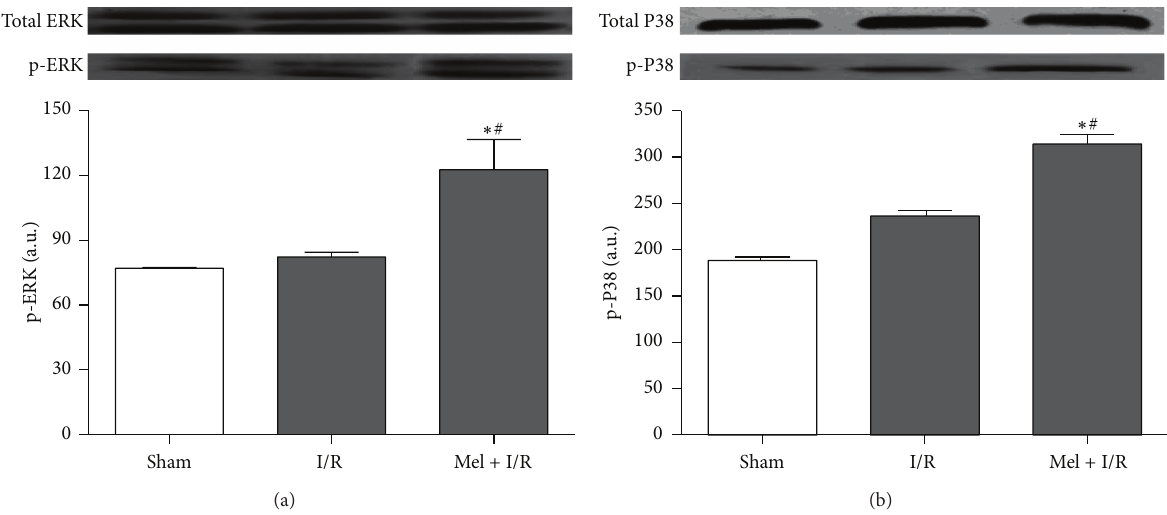
Figure 6: Western blot of total and phosphorylated ERK (a) and total and phosphorylated P38 (b). One representative blot of six independent experiments is shown at the top whereas densitometric analysis is shown at the bottom. Results are expressed as mean ± SEM. ∗ 𝑝 < 0.05 versus Sham. # 𝑝 < 0.05 versus